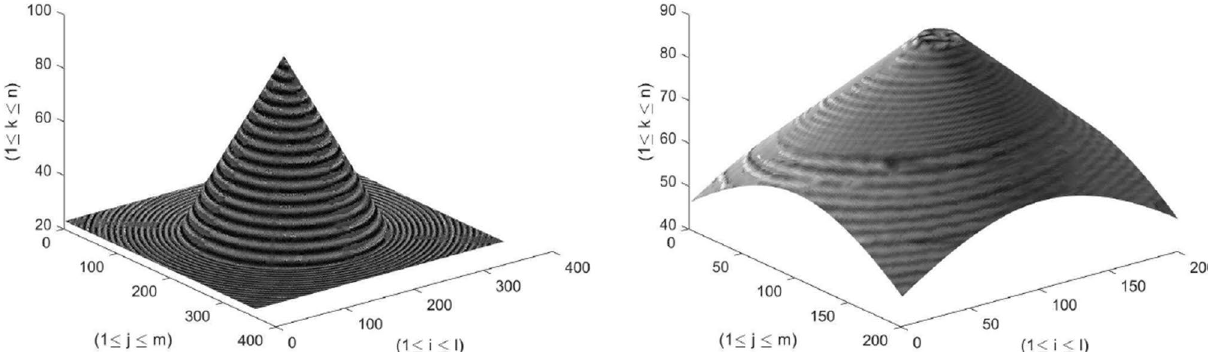
Figure 4. Ground truth of Simulated Cone and Real Cone.